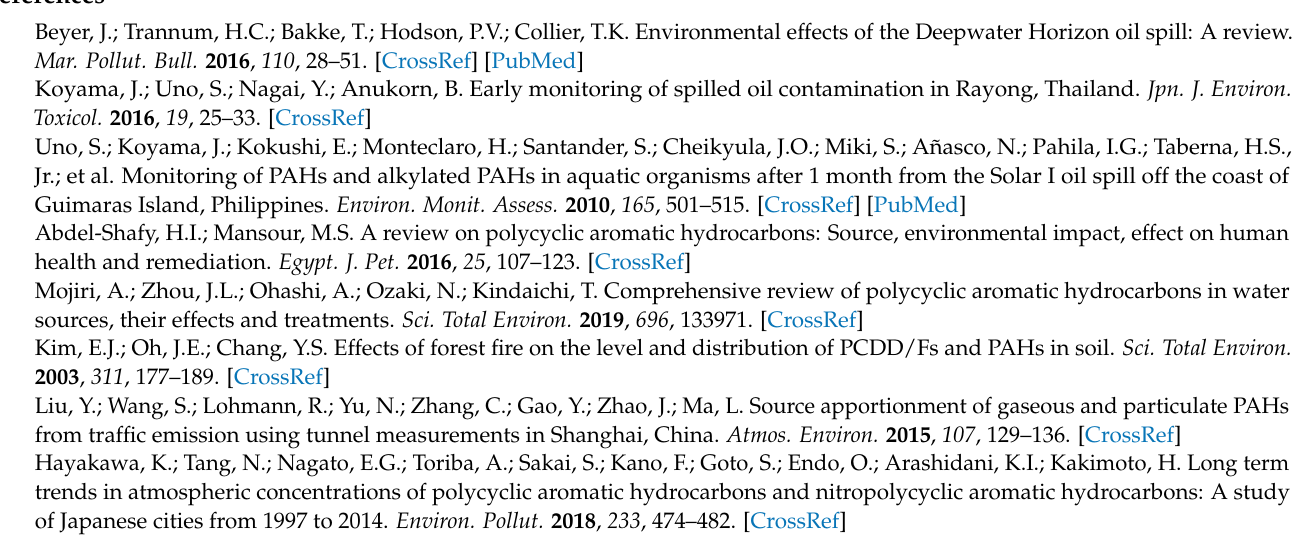
Figure S2: Loading plot for the first two principal components (accounting for 88% of the variance), Table S1: Gas chromatography (GC) and mass spectrometry (MS) conditions, Table S2: Mass transition and approximate retention time of target analytes and internal standards, Table S3: Total concentration of PAHs grouped by ring number in samples from 12 sampling sites (ng/g-dw or